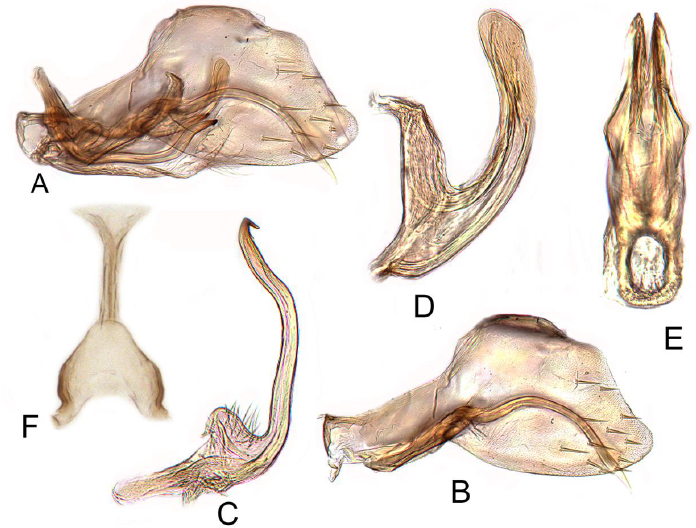
1.8 – 2.3 mm wide across hind margin of pronotum.